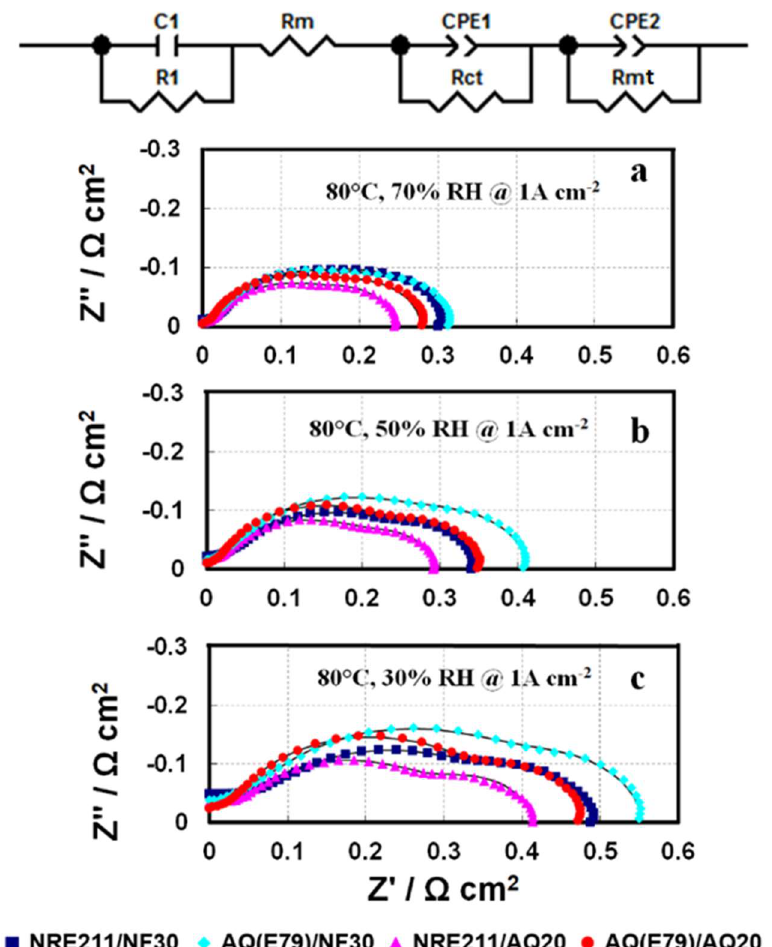
Figure 8. In-situ electrochemical impedance spectra of four investigated MEAs at a current density of 1.0 A cm 2 at 80 °C under RH of ( a ) 70%; ( b ) 50%; and ( c ) 30%.